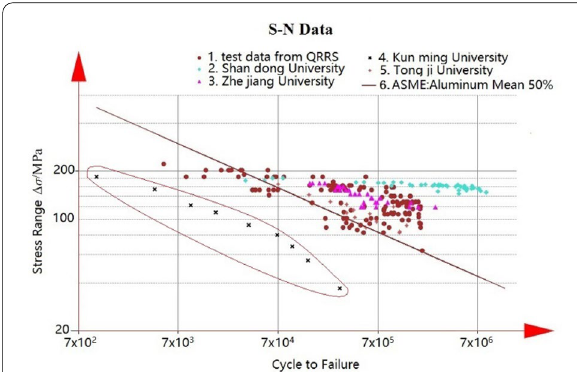
Figure 24 Comparison of applicability of the master S–N fit